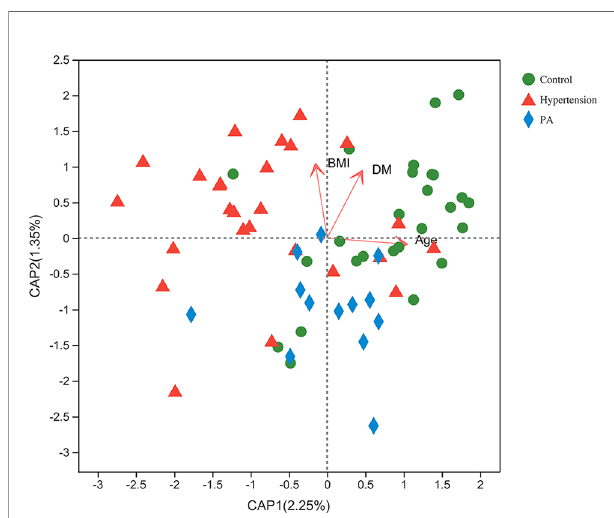
FIGURE 4 | Bray – Curtis distance-based redundancy analysis (dbRDA) of the gut microbiota and explanatory factors in primary aldosteronism (PA) patients, primary hypertension patients, and healthy controls.